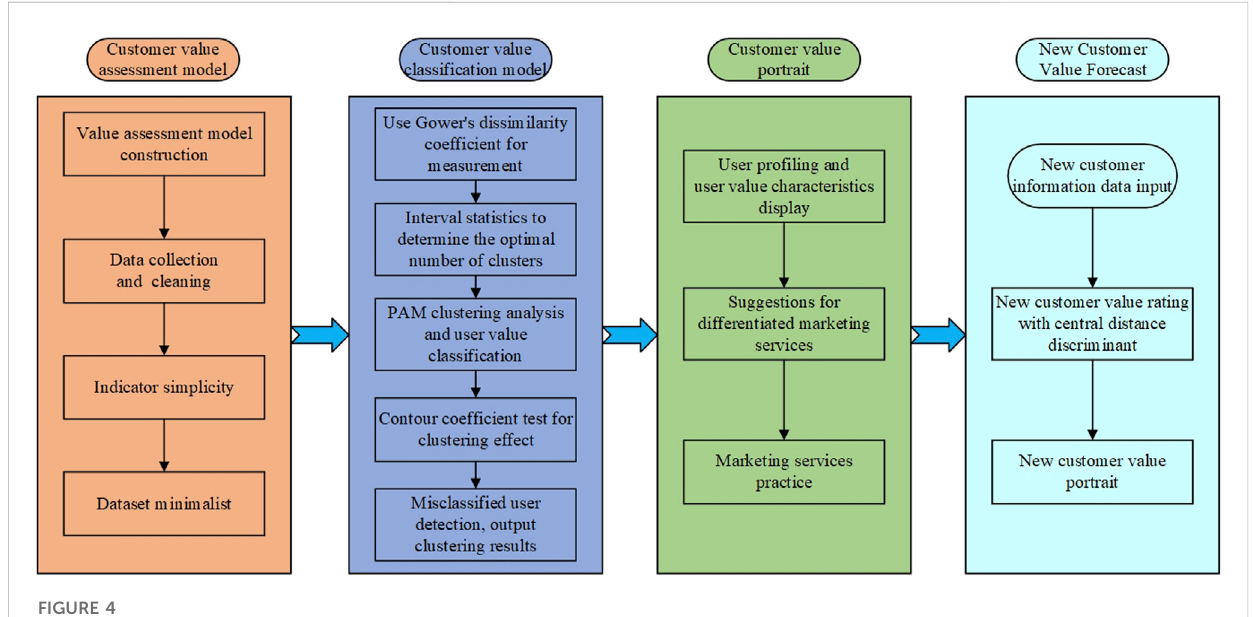
FIGURE 4 Process of the natural gas industrial customer value